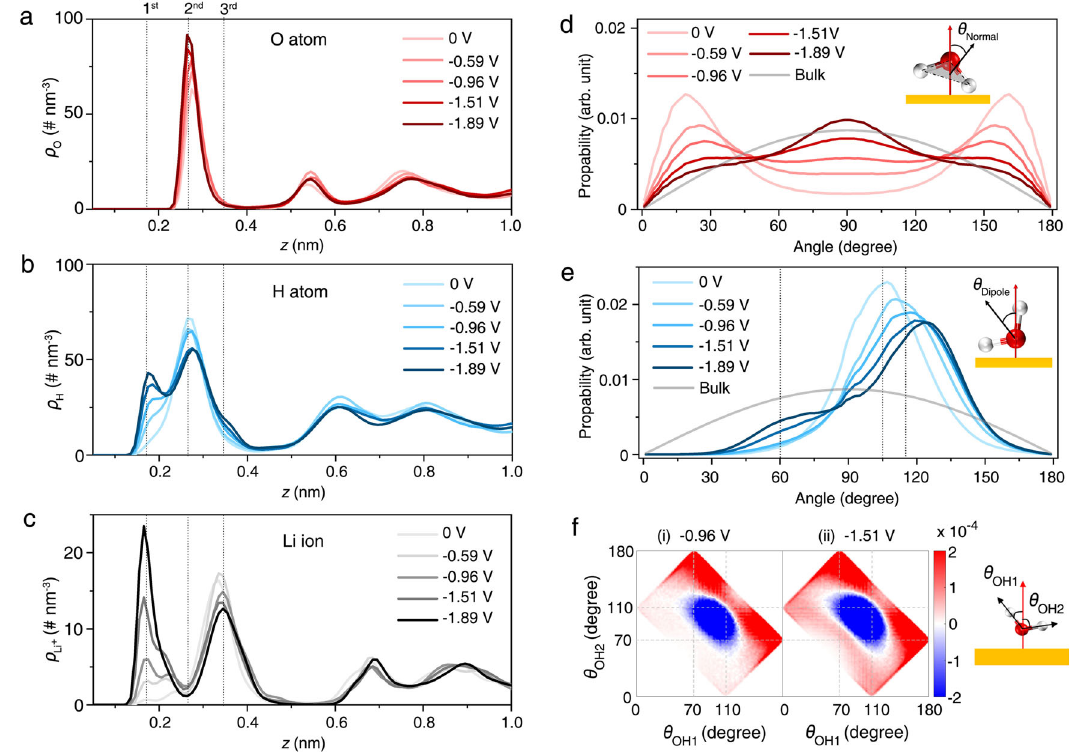
Fig. 3 | Microscopic structure of the electrical double layer at Au(111)|WiS electrolyte (21m LiTFSI) interface. a – c Atom number densities ( ρ ) of oxygen ( a ) and hydrogen ( b ) of water, and Li + ( c ) in 21m LiTFSI aqueous electrolyte. d , e , Normal orientation ( d ) and dipole orientation ( e ) of interfacial water. The normal orientation is de fi ned as the angle between the normal of the water plane andthenormaloftheelectrodesurface;thedipoleorientationistheanglebetween the water vector and the normal of the electrode surface. The solid gray line